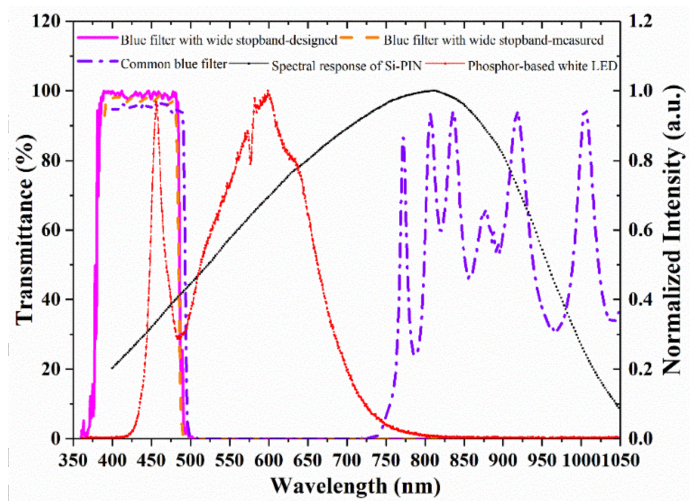
Figure 10. Calculated and measured transmission spectra of the blue filter, as well as the normalized emission spectrum of a phosphor-based white LED and the typical spectral response of a Si-based receiver for reference [2]. Reproduced with permission from [2], IEEE, 2015. (Reprinted from IEEE Wireless Communications, 22, Wang, S. W. etc., A high-performance blue filter for a white-led-based visible light communication system. 61–67, Copyright (2015), with permission from IEEE.)